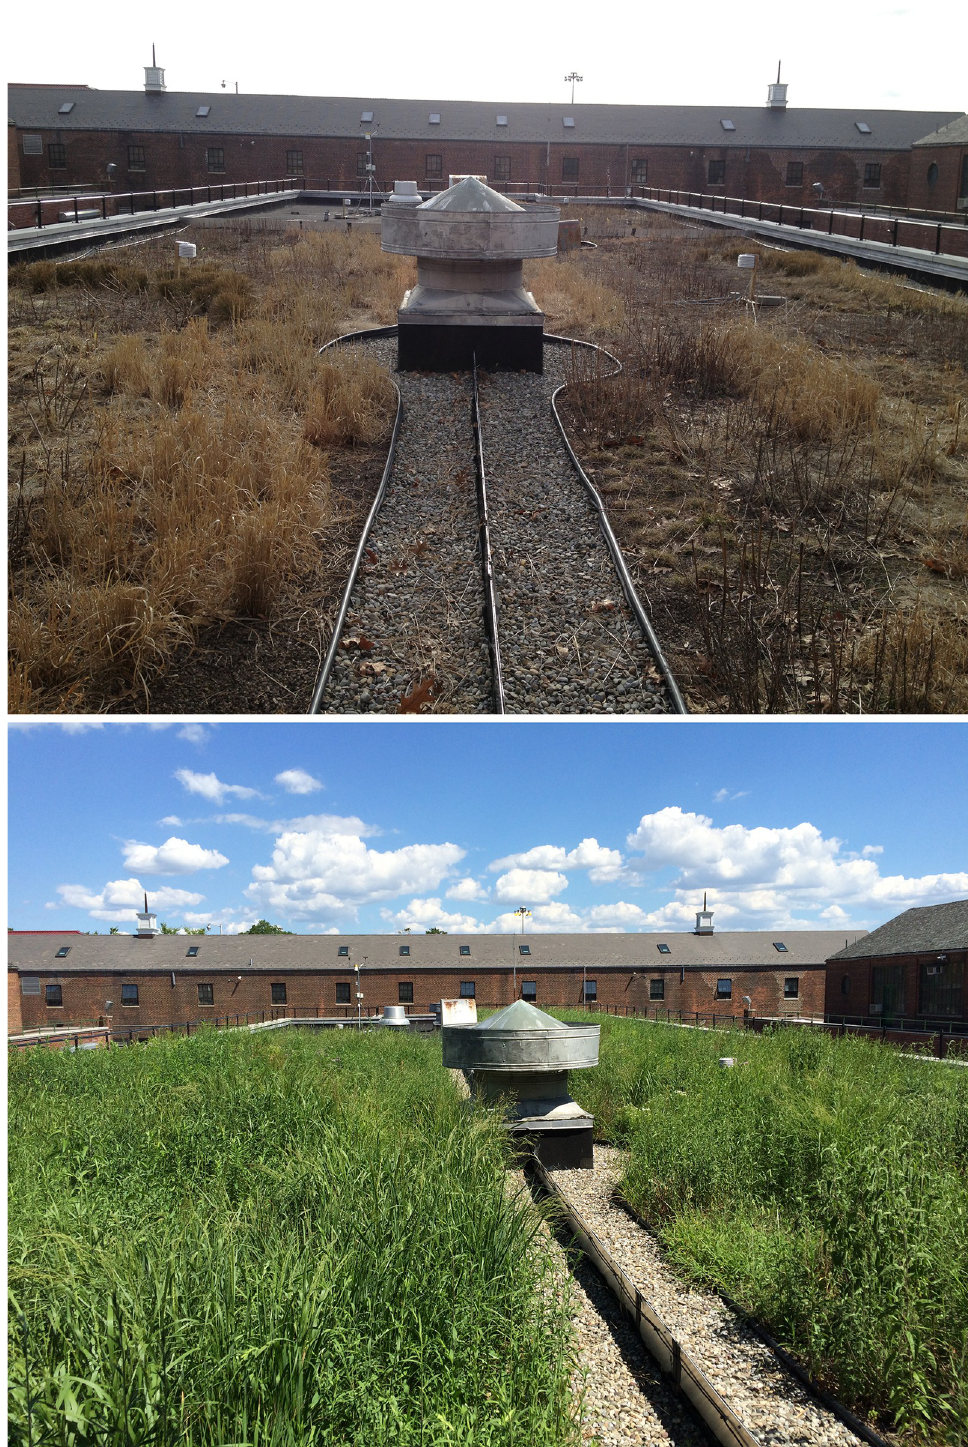
Fig 9. Ranaqua green roof during the (a) winter; (b)